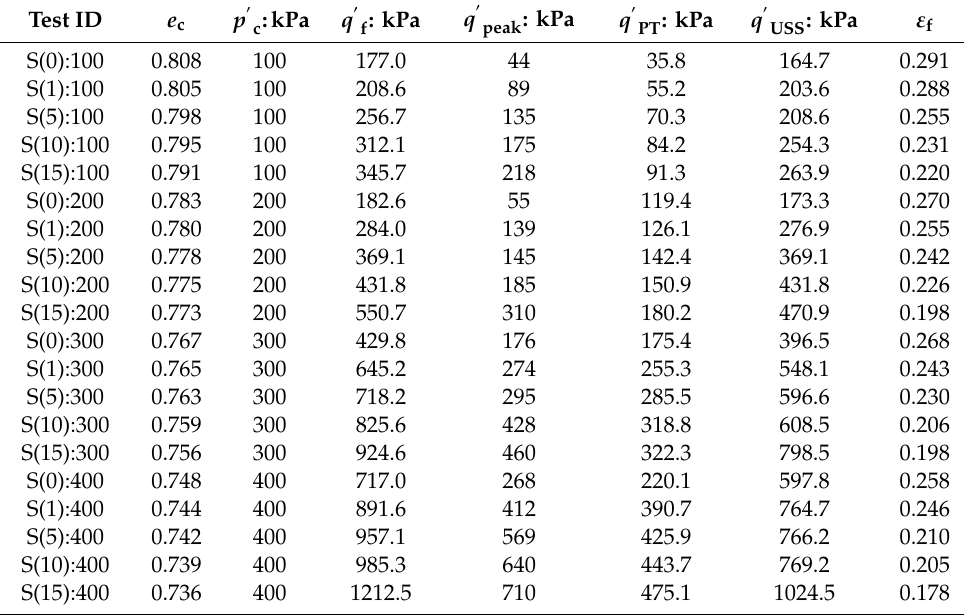
Table 5. Testing program and steady